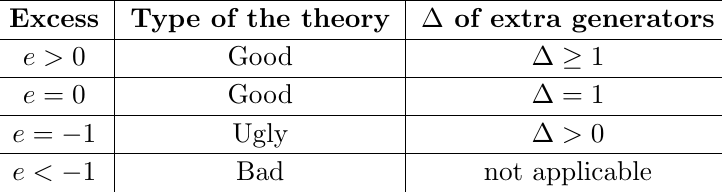
Table 2 . Types of minimally unbalanced quiver gauge theories based on excess of the extra node.